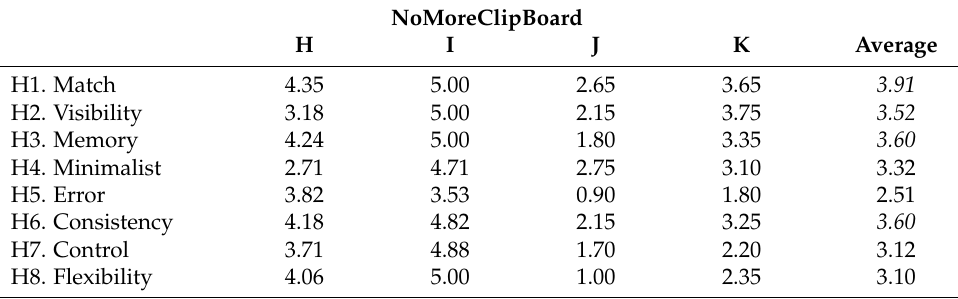
Table 6. Average usability assessments in NoMoreClipBoard.